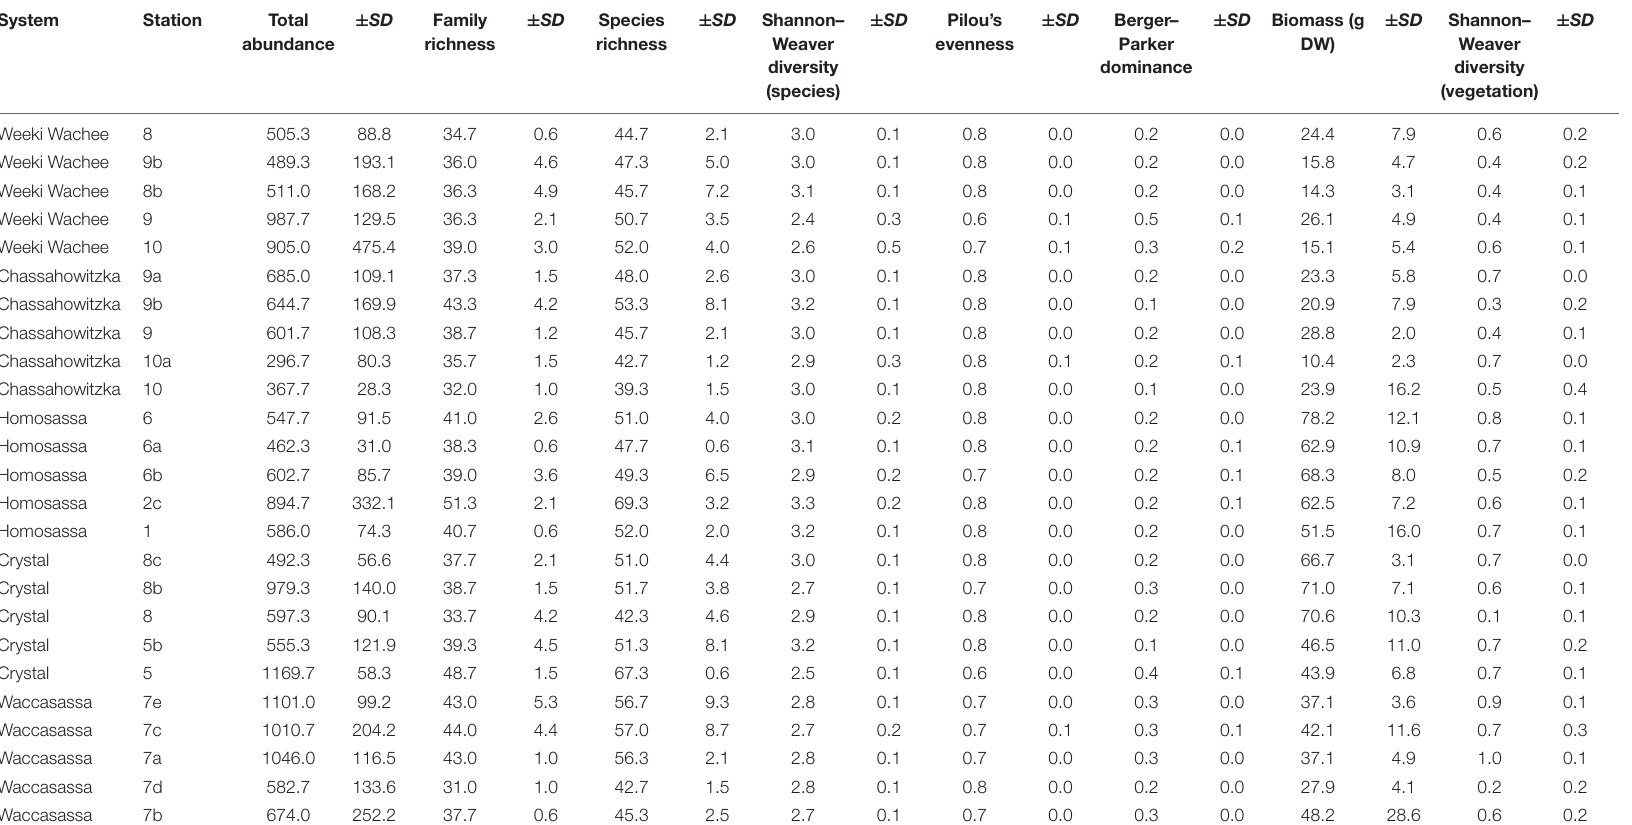
TABLE 1 | Univariate community indices (mean ± standard deviation) summarized by station ( n = 5 per station). ± SD Family ± System Station Total abundance richness